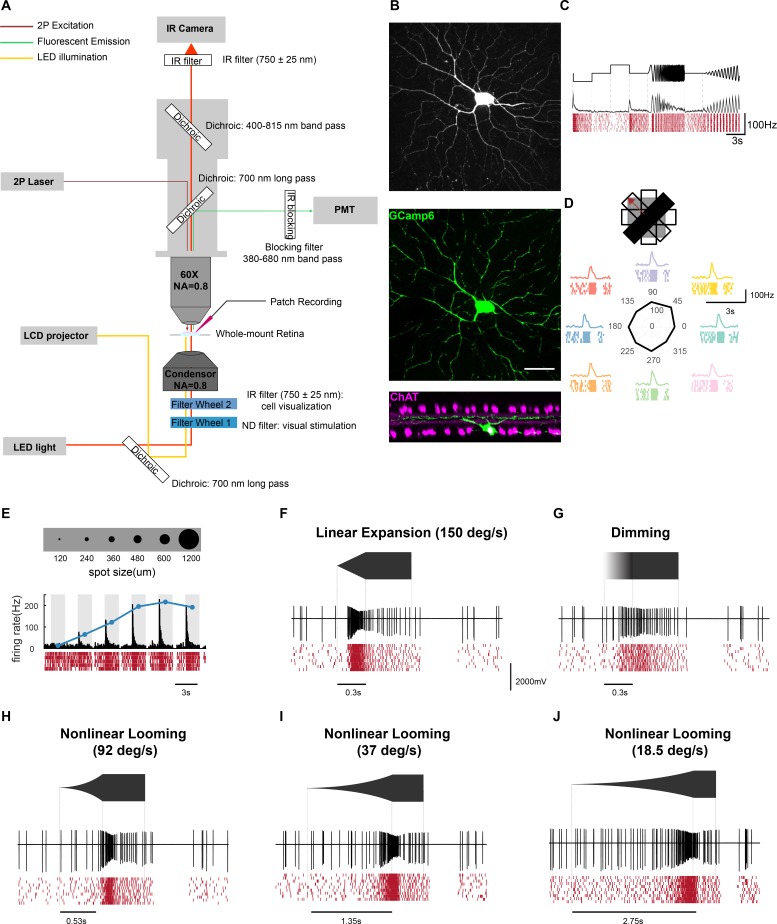
Targeted patch-clamp recording of virus-labeled retinal ganglion cells.(A) Schematic of the setup for the two-photon targeted patch-clamp recording. (B) Top: Maximum intensity projection of a two-photon image stack showing a GCaMP6-expressing cell after the rabies injection. En-face view (middle) and side-view (bottom) of a confocal microscope z-stack (maximum intensity projection) showing the same cell after the staining process (green: GCaMP6, magenta: ChAT). Scale bar: 50 μm. (C) Response of this cell to the chirp stimulus. The black trace representing the mean firing rates (50 ms bins) across 10 trials, which are shown below in the raster plot (red). (D) Response to the black fast moving bar. (E) Response to spot stimuli consisting of a black spot presented for 2 s with 120, 240, 360, 480, 600 and 1200 μm diameter. The gray bars indicate stimulus duration. The blue line represents the spot size tuning curve. (F) Response to a linearly expanding black dot. (G) Response to a large dot that linearly dimmed from gray to black. (H–J) Responses to non-linearly expanding black dots at different speeds.